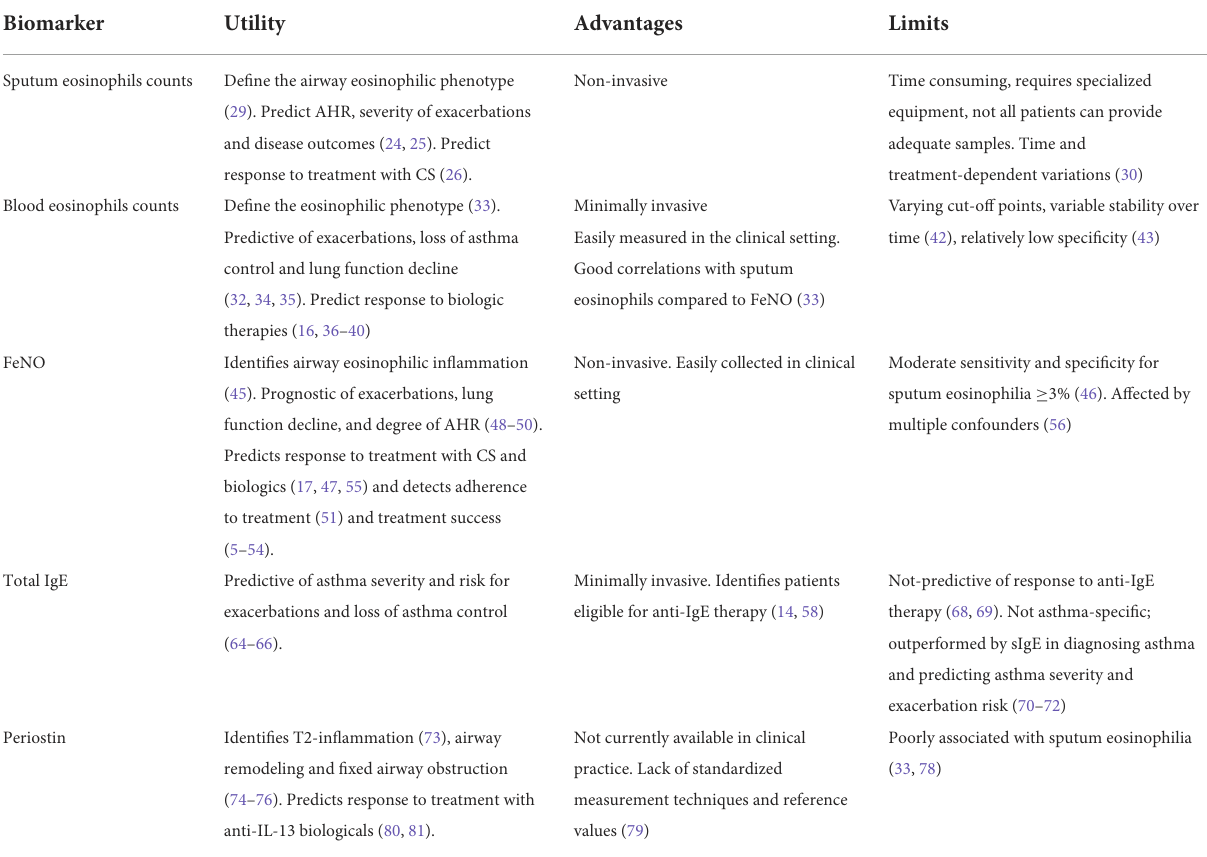
TABLE 1 Summary of characteristics of major